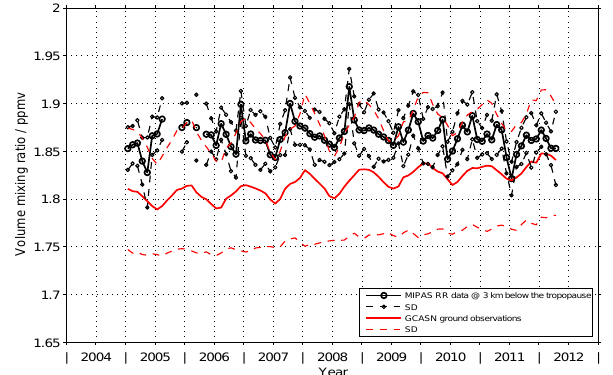
Figure 3. Comparison of CH 4 from SCIAMACHY and MIPAS re- duced resolution (V5R_CH4_225 and V5R_CH4_224). Details as in Fig. 1.